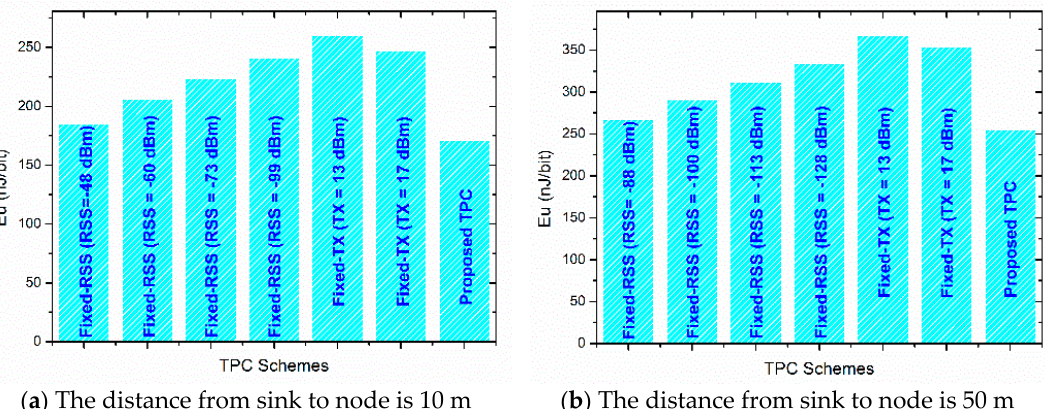
Figure 10. Average transmission cost for different schemes.